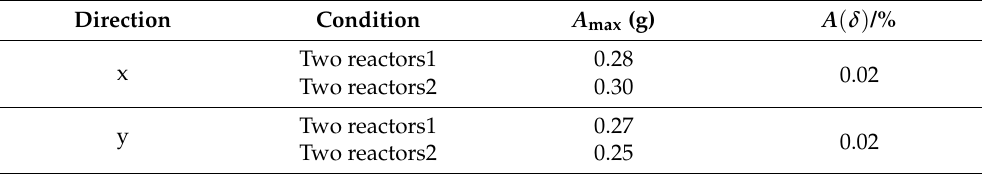
Table 3. Comparison of peak acceleration of the two reactors at the same site.